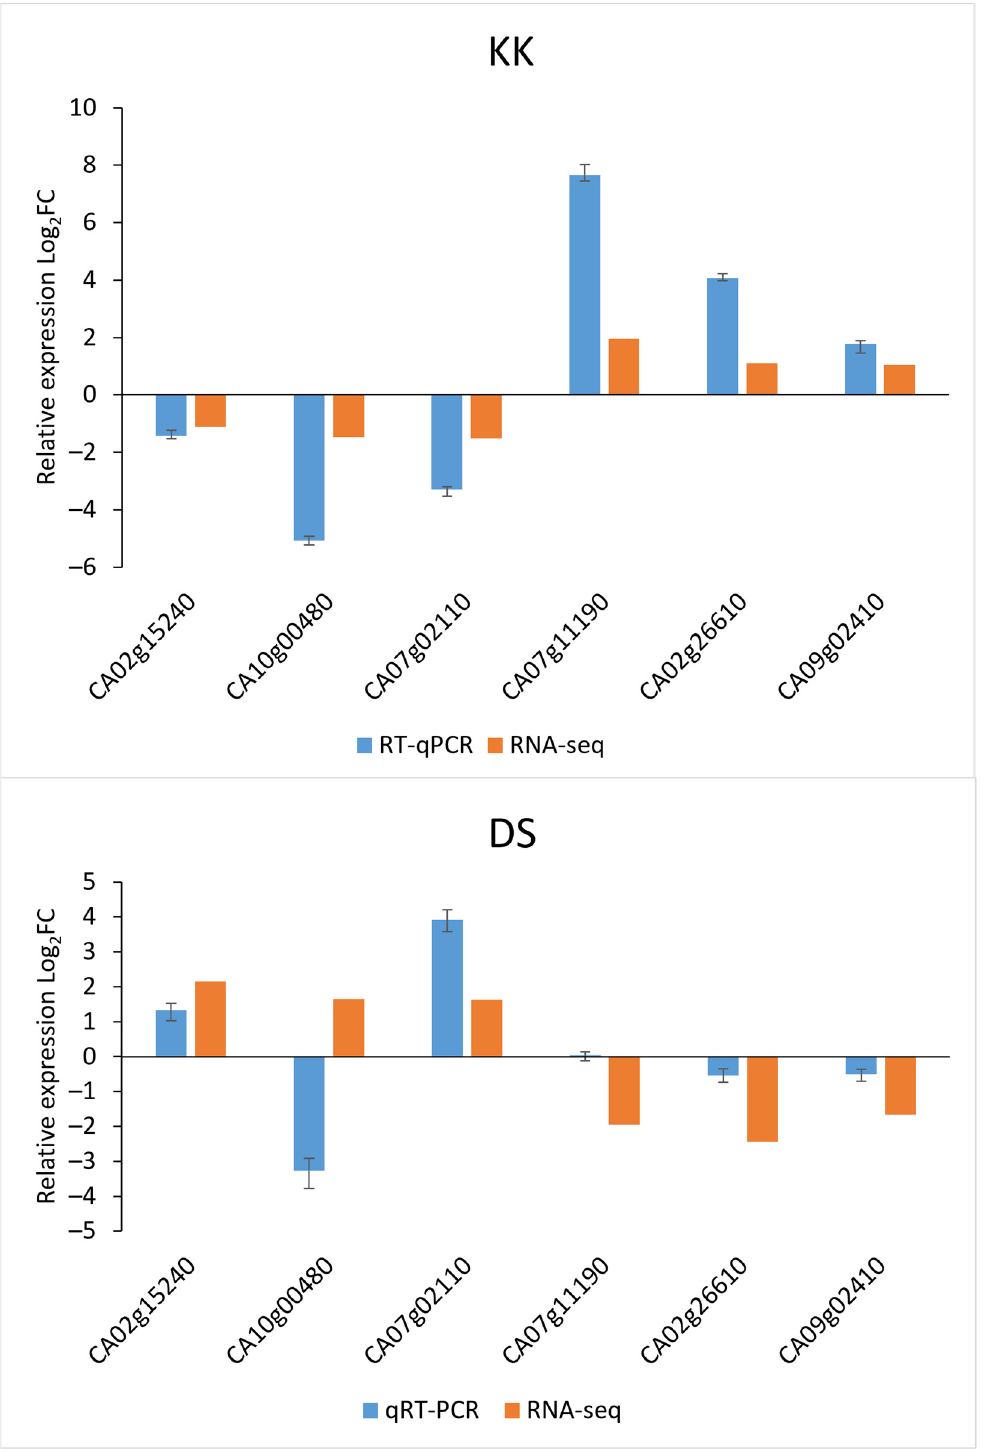
Figure 5. The relative quantification of the expression of selected genes by RT-qPCR and RNA-seq in KK and DS plants infected with PSTVd at 43 dpi.